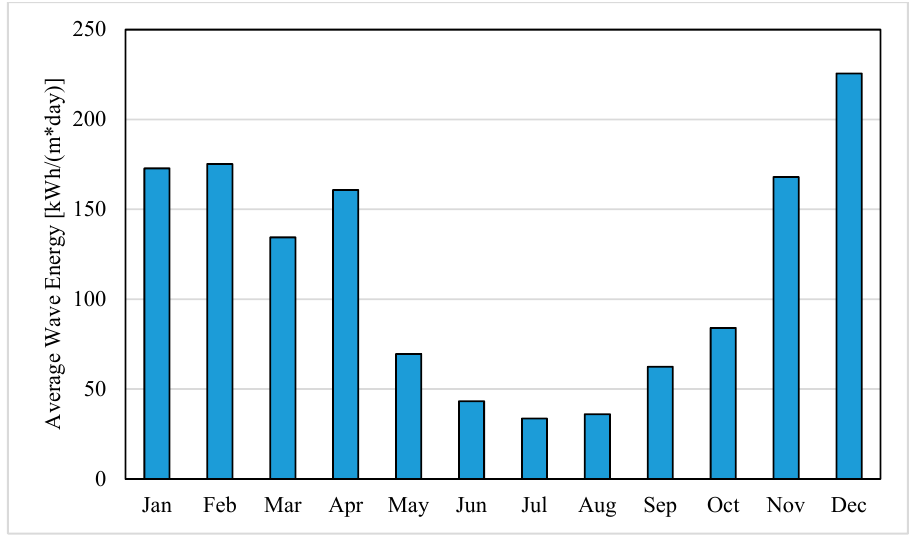
Figure 5. Evaluation of sea wave energy in Sicily for the year 2013.